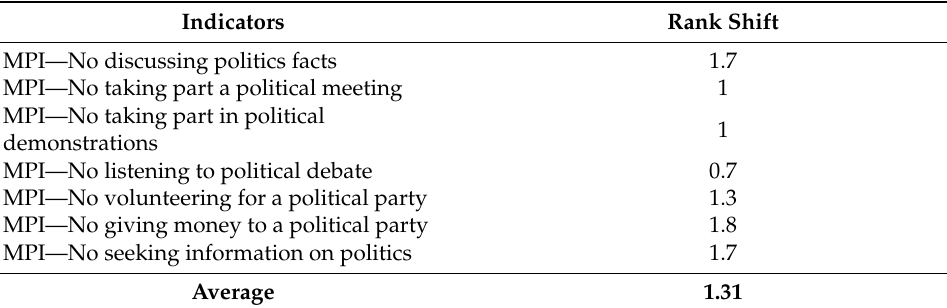
Table 3. The validation of Political Participation